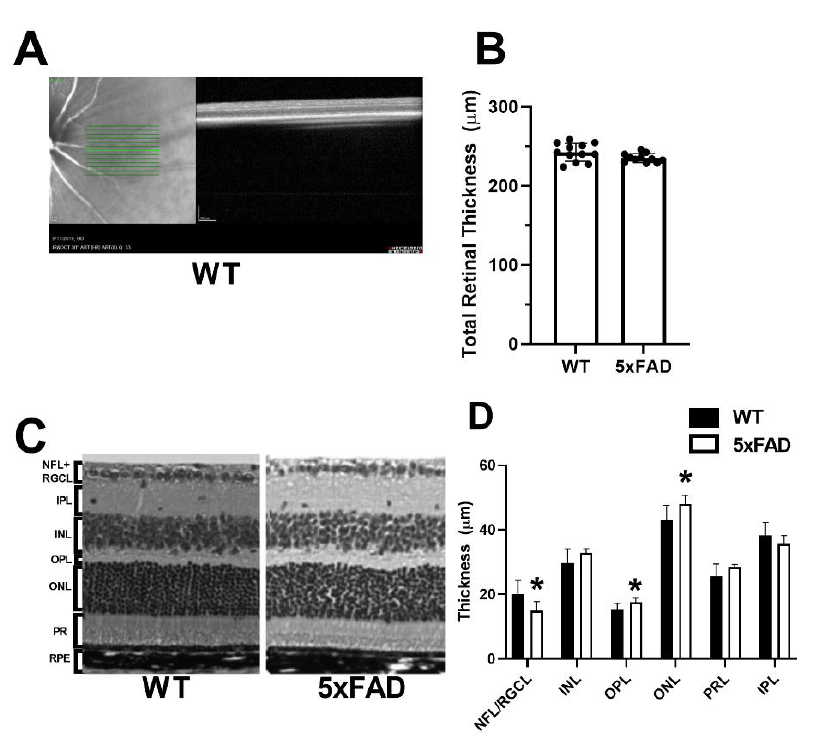
Figure 4. Measurements of total and retinal layer thickness in wild-type (WT) and five-familial Alzheimer’s disease (5XFAD) mice. ( A ) Region of imaging and representative optical coherence tomography image of the retina. ( B ) Total retinal thickness measured by spectral domain optical coherence tomography. ( C ) Representative retinal layer thicknesses measured from histological sections. ( D ) Thickness measurements of nerve fiber layer/retinal ganglion cell (NFL/RGCL), inner plexiform layer (IPL), inner nuclear layer (INL), outer plexiform layer (OPL), outer nuclear layer (ONL), and photoreceptor layer (PRL). The data are presented as mean ± SD. * p < 0.05.